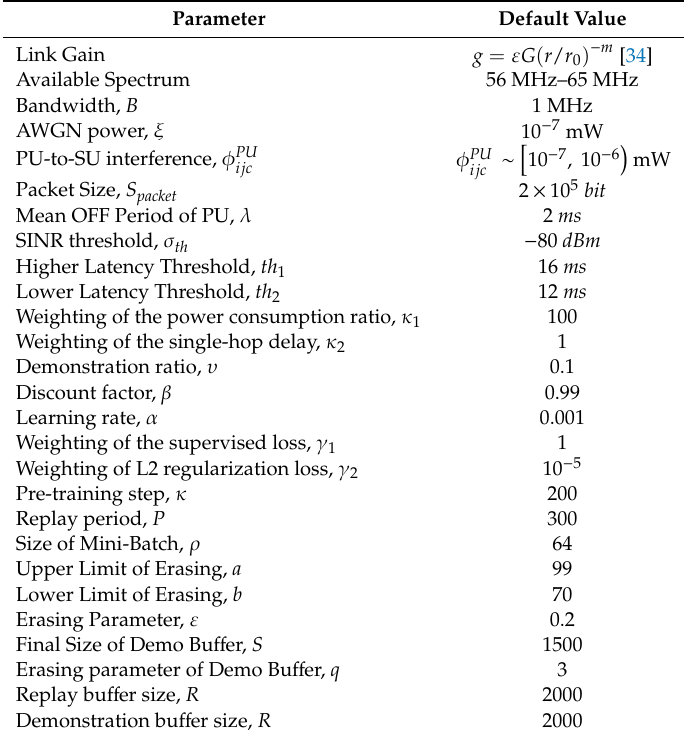
Table 1. Simulation parameters.